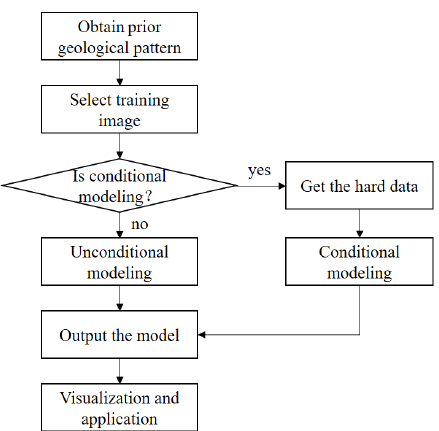
Figure 8. Workflow of facies modeling using improved GANs method.